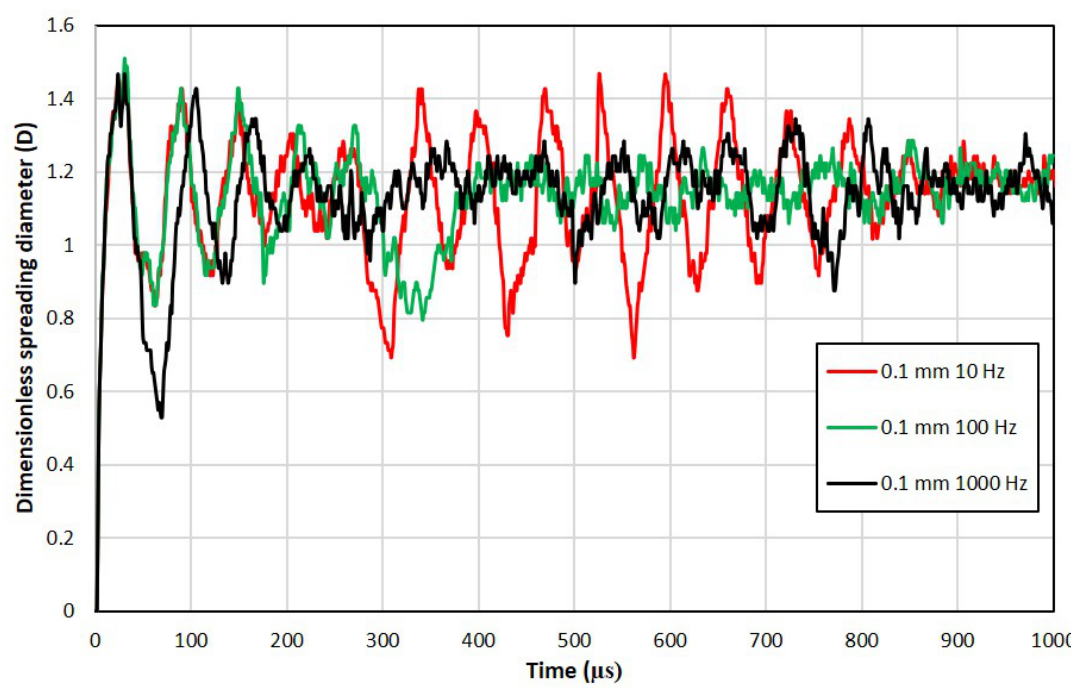
Figure 14. Droplet oscillations for a surface vibration amplitude of 0.1 mm at frequencies of 10 Hz, 100 Hz, and 1000 Hz.